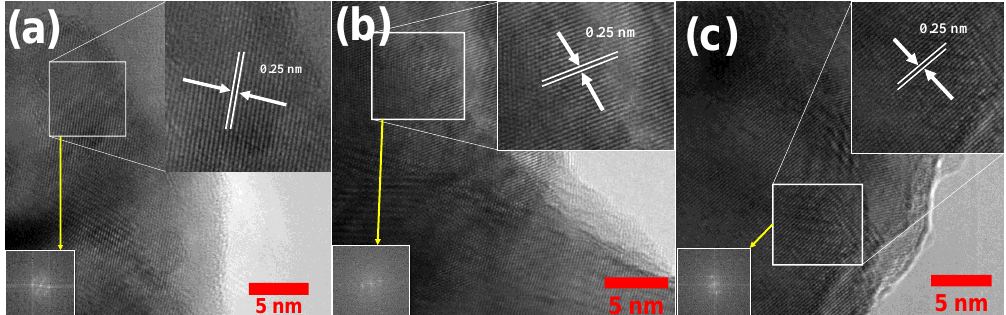
Figure 6. TEM images of pure and Zn-doped CuO samples ( a ) P, ( b ) S3, and ( c ) S6.